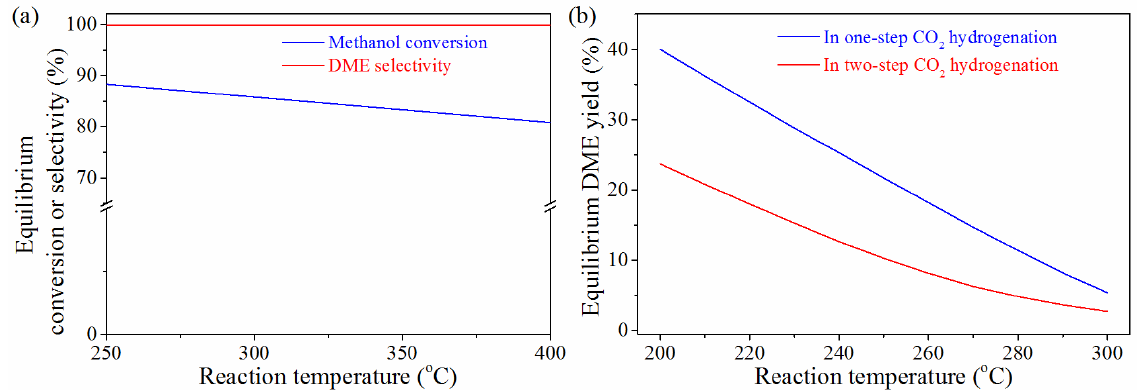
Figure 3. Thermodynamic results in the equilibrium reactions. ( a ) Equilibrium methanol conversion and DME selectivity in the methanol dehydration. ( b ) Equilibrium DME yield in the one-step or two-step CO 2 hydrogenation. Reproduced with permission from Shen et al. [35] and Palomo et al. [42], respectively published by Springer Nature, 2000, and Elsevier, 2019.